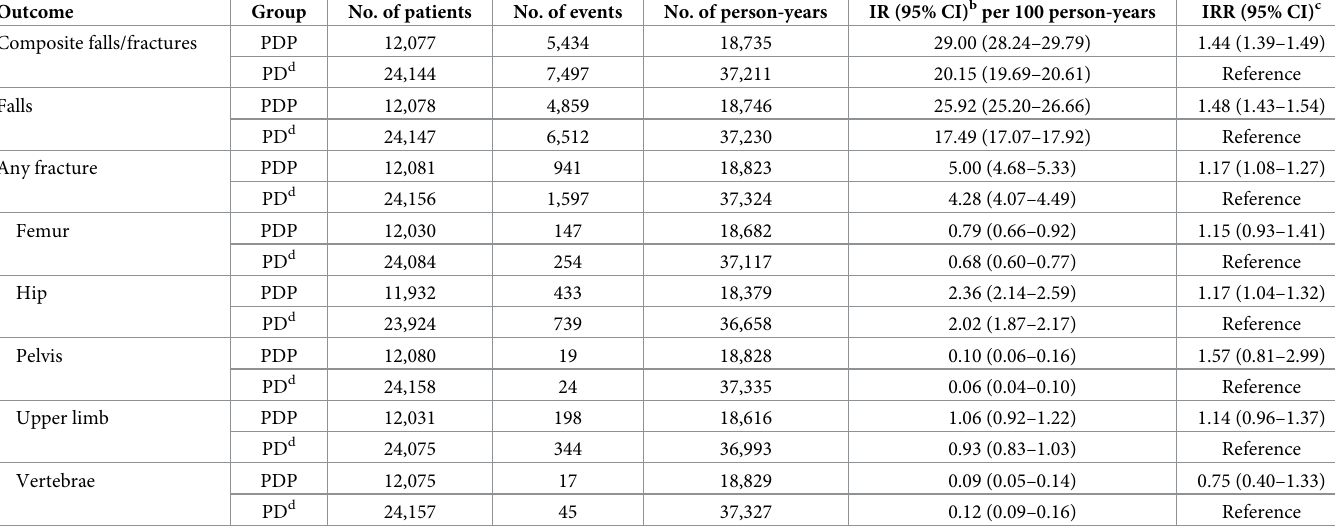
Table 3. Incidence rates and incidence rate ratios of falls and fractures for the matched PD-PDP cohort a .